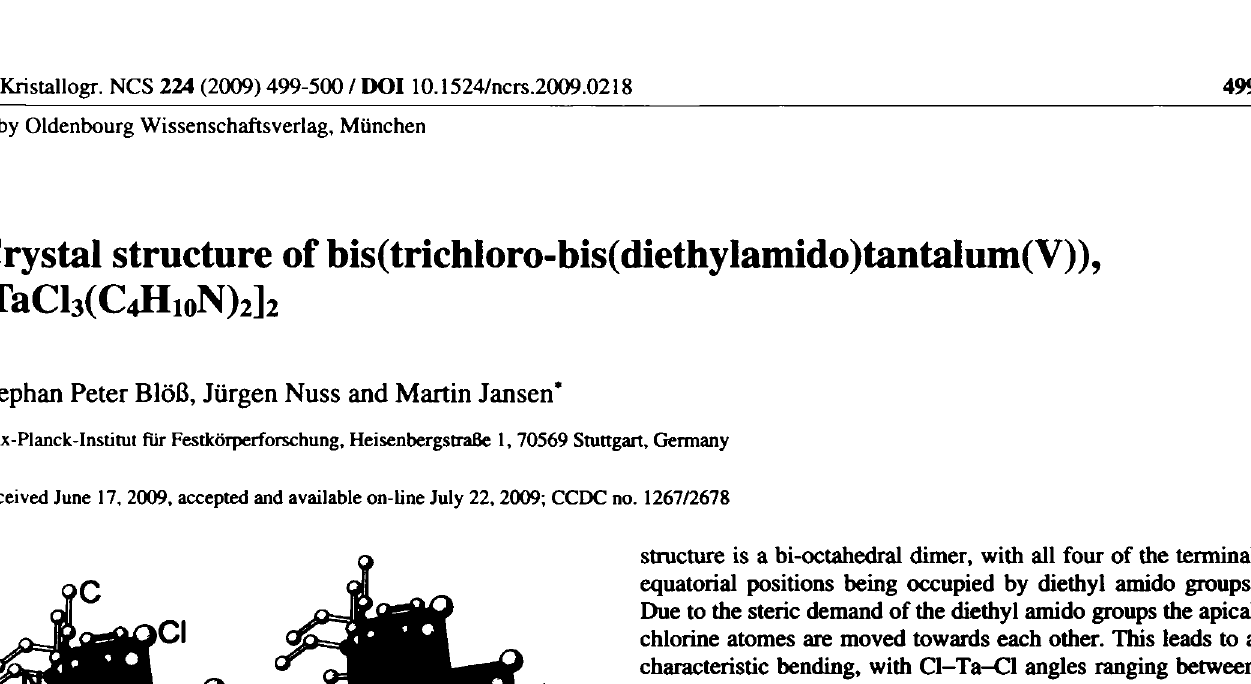
Table 1. Data collection and handling.